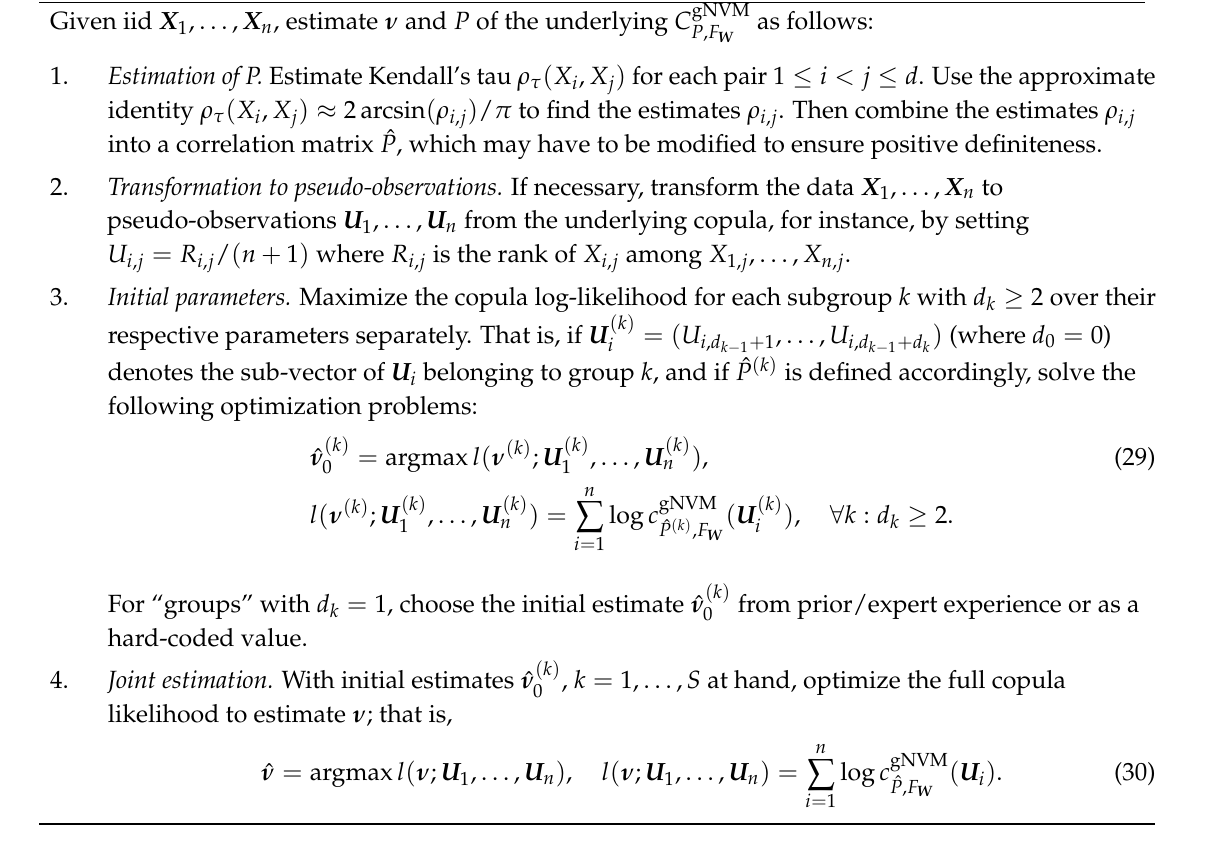
Algorithm 2: Estimation of the Copula Parameters ν and P of C gNVM Given iid X 1 , . . . , X n , estimate ν and P of the underlying C gNVM